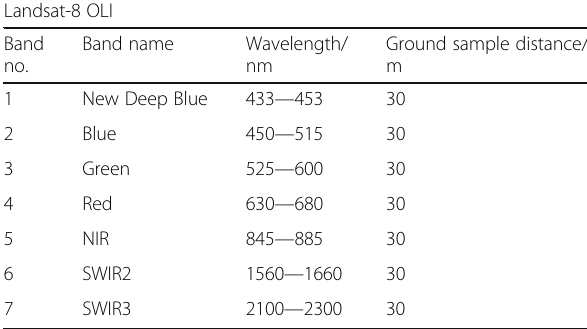
Table 1 The information of the Landsat-8 OLI data